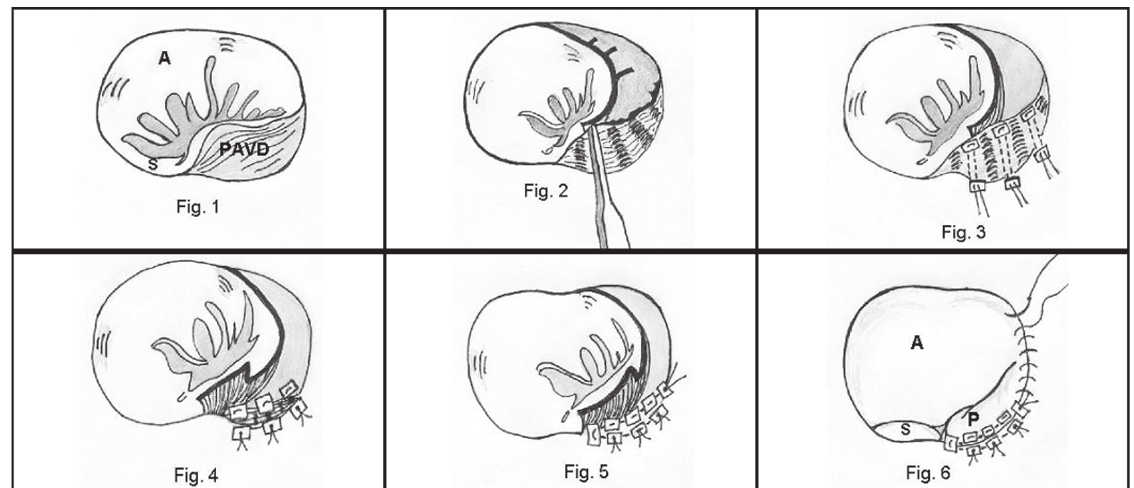
Fig. 1 - A = folheto anterior; S = folheto septal; PAVD = porção atrializada do VD. Fig. 2 – Desinserção do folheto anterior. Fig. 3 – Plicatura longitudinal da PAVD. Fig. 4 – Plicatura longitudinal, diminuição do anel valvar. Fig. 5 – Anuloplastia do folheto anterior. Fig. 6 – Reinserção do folheto anterior - aspecto